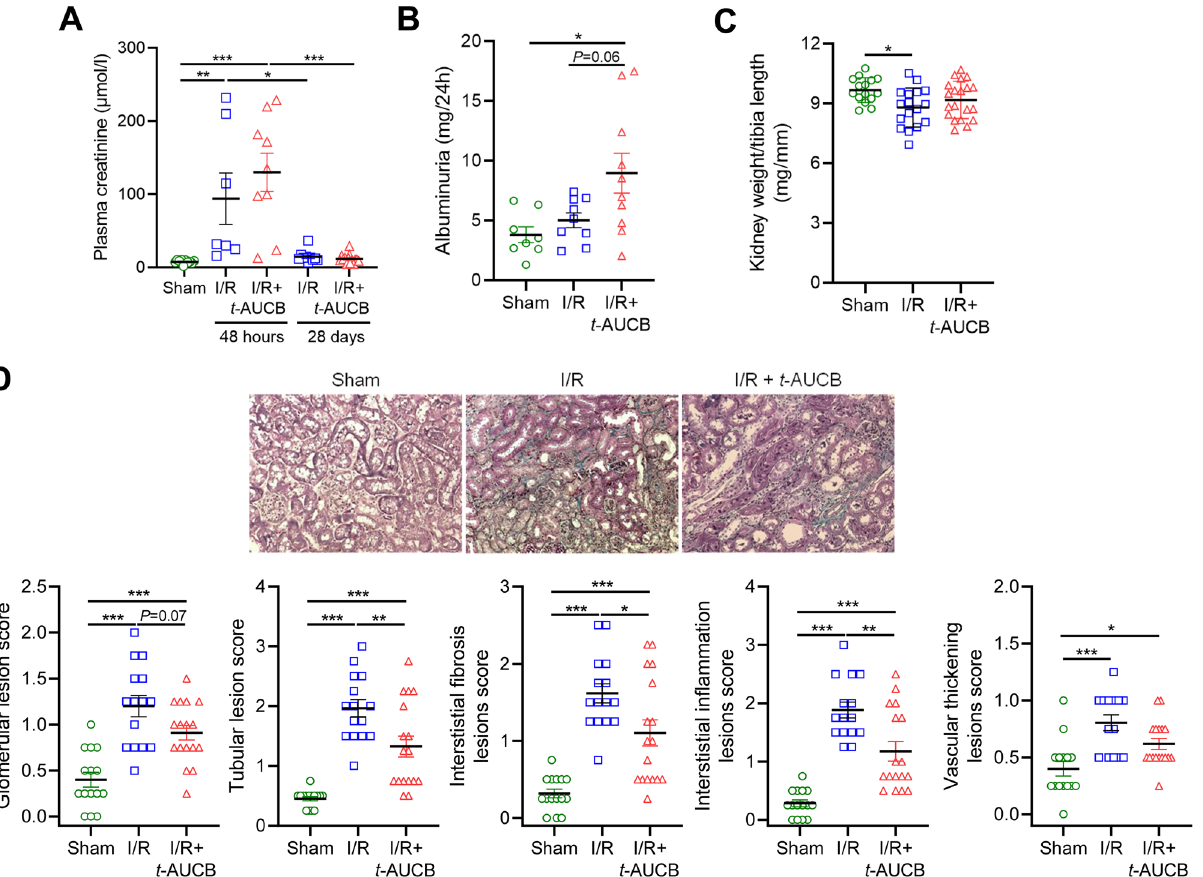
Figure 6. Impact of soluble epoxide hydrolase inhibition on kidney damage induced by renal-ischemia reperfusion injury. Plasma creatinine at day 2 and day 28 after surgery ( A ), 24-h urine albumin excretion ( B ), kidney weight ( C ), representative images and scoring of kidney lesions at sacrifice ( D ) 28 days after surgery in sham-operated mice and mice subjected to bilateral renal ischemia/reperfusion (I/R) treated or not with the soluble epoxide hydrolase inhibitor t -AUCB. * P <